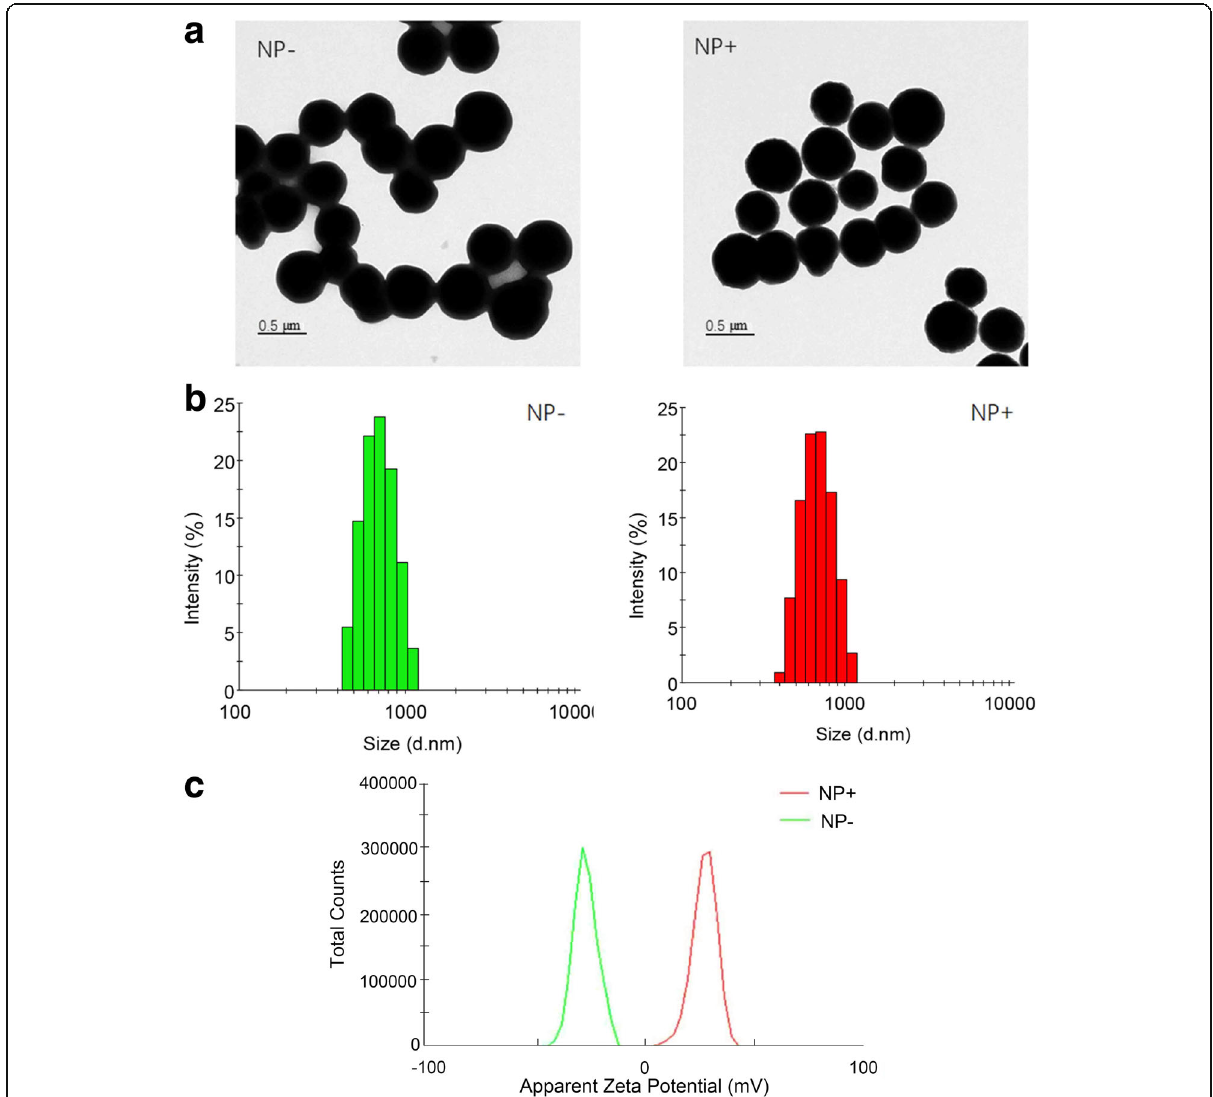
Fig. 2 Characterization of the nanoparticles. a Transmission electronic microscopy (TEM) image of positively charged nanoparticles (NP+) and negatively charged nanoparticles (NP − ). b Dynamic light scattering size and distribution of NPs. c Zeta potential distributions of